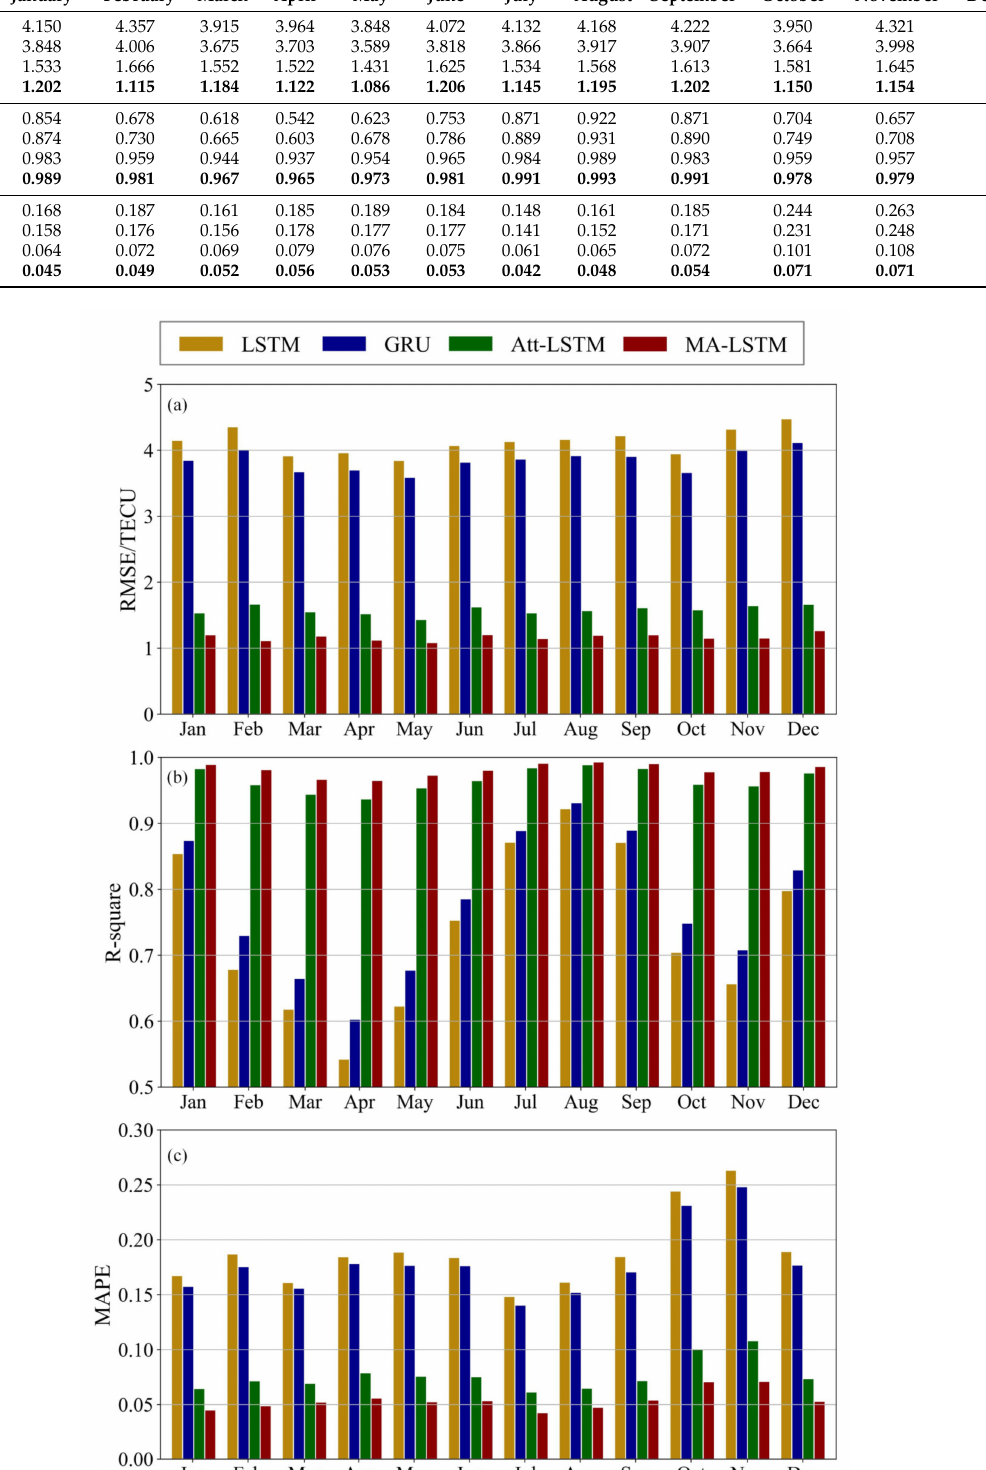
Figure 9. Comparison of ( a ) RMSE, ( b ) R-square, and ( c ) MAPE values for various models in different